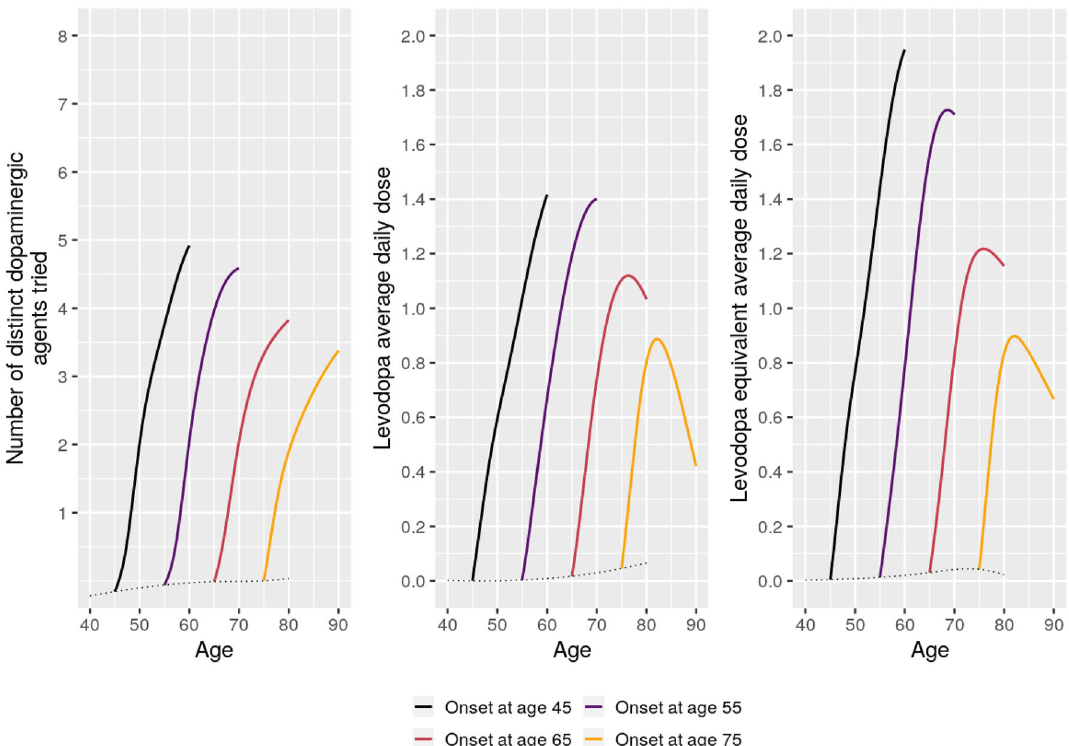
Figure 8. Estimated 15-year mean trajectories of treatment outcomes from Parkinson’s disease onset at respectively 45, 55, 65, and 75 years of age. Trajectories estimated based on data from 205,463 prescriptions and pick-ups mapped to 3407 visits. Dotted line represents the estimated mean scores for patients with onset at the given